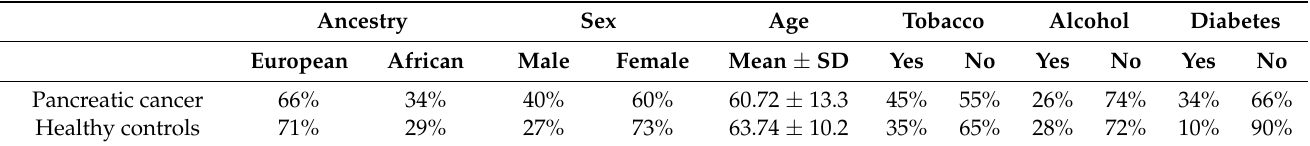
Table 1. Epidemiological data for pancreatic cancer and healthy control for ancestry, gender, age, tobacco, and alcohol usage and diabetes. Ancestry Sex Age Tobacco Alcohol